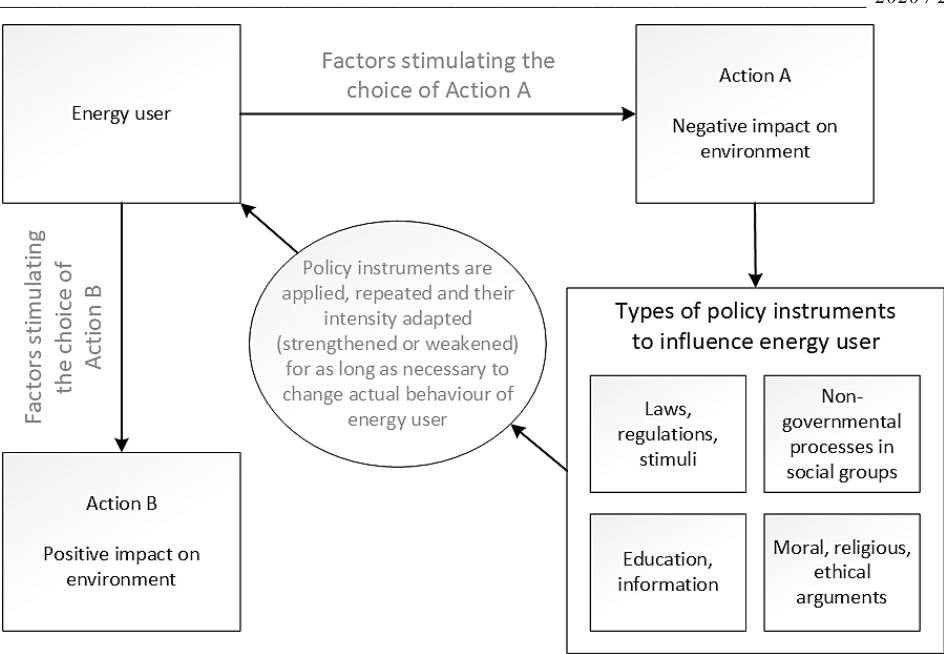
Fig. 3. Schematic representation of the impact on energy